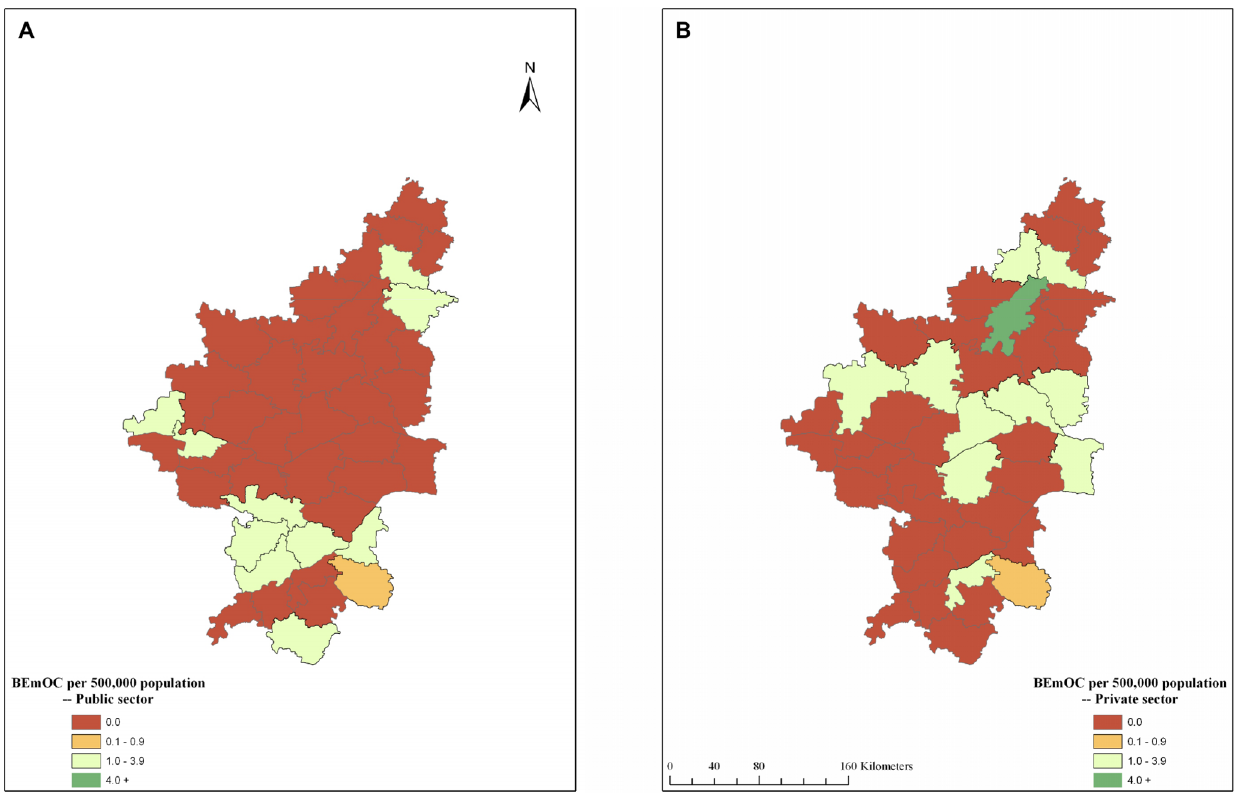
Figure 4. Geographic distribution of government and private BEmOC facilities in 42 taluks of northern Karnataka, 2010. A. Government sector EmOC. B. Private sector EmOC. BEmOC=Basic Emergency Obstetric Care.